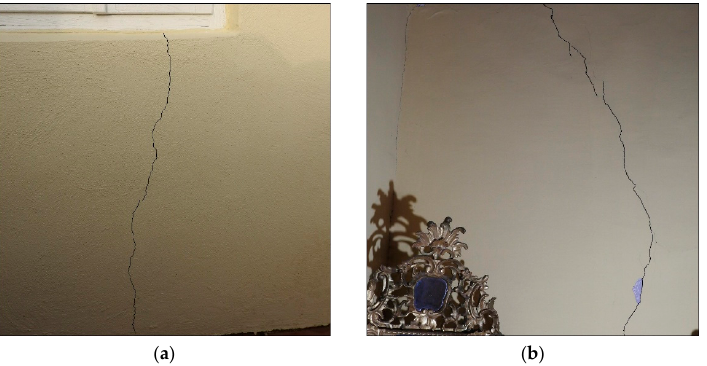
Figure 15. ( a ) Hairline crack of width <1 mm in the crown of an arch (ID 12 in Figure 10a); ( b ) Crack of width <3 mm on the 2nd floor wall (ID 52 in Figure 10d).